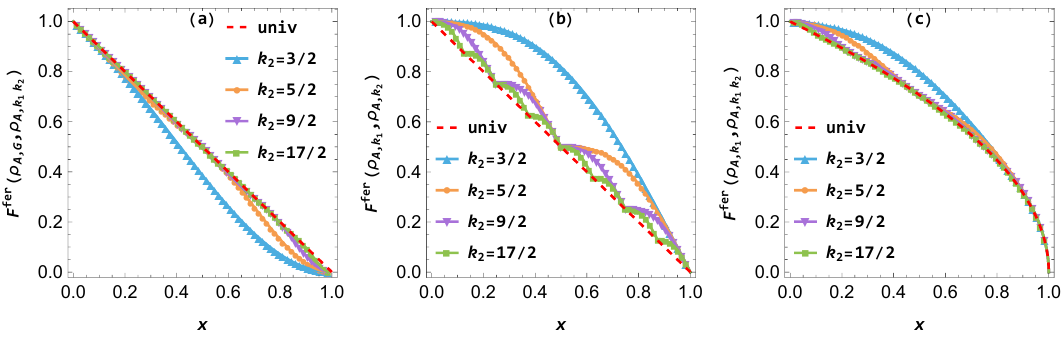
Figure 2 . The universal fidelities from the semiclassical quasiparticle picture (3.76), (3.78) and (3.80) (dashed red lines), the analytical fidelities from the subsystem mode method (3.74), (3.77) and (3.79) (solid lines), and the corresponding numerical results from the diagonalized truncated correlation matrix method (symbols) in the free fermionic chain. We have set L = 64 , k with F fer (3.53). With D fer ( ρ ) (3.52) and the fact that 0 ≤ F fer , ρ A,G A,K 1 A,G,K easy to see the expected inequality [1,